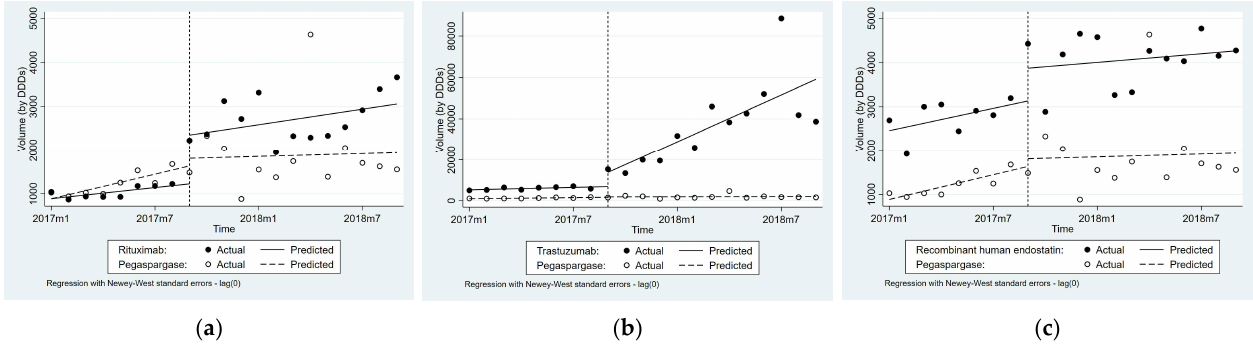
Figure 2. Average procurement volume based on DDDs of the three targeted anticancer drugs: ( a ) Rituximab; ( b ) Trastuzumab; ( c ) Recombinant human endostatin.